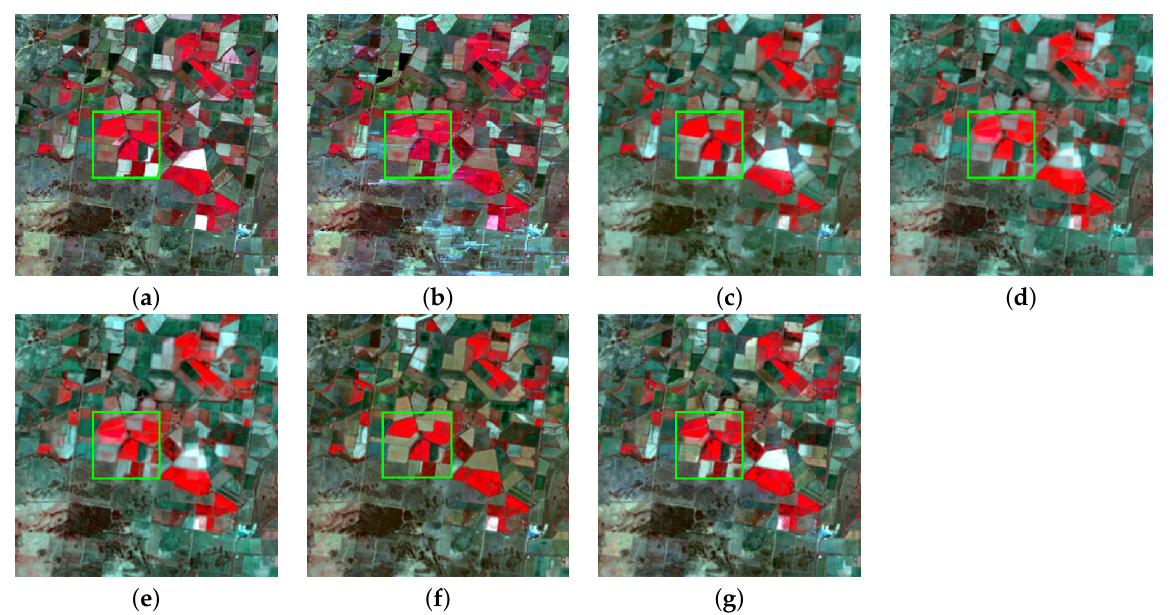
Figure 8. CIA dataset of real image acquired on 4 May 2002 and predicted images generated by each fusion method. ( a ) Observed. ( b ) STARFM. ( c ) FSDAF. ( d ) DCSTFN. ( e ) EDCSTFN. ( f ) AMNet. ( g ) Proposed method.